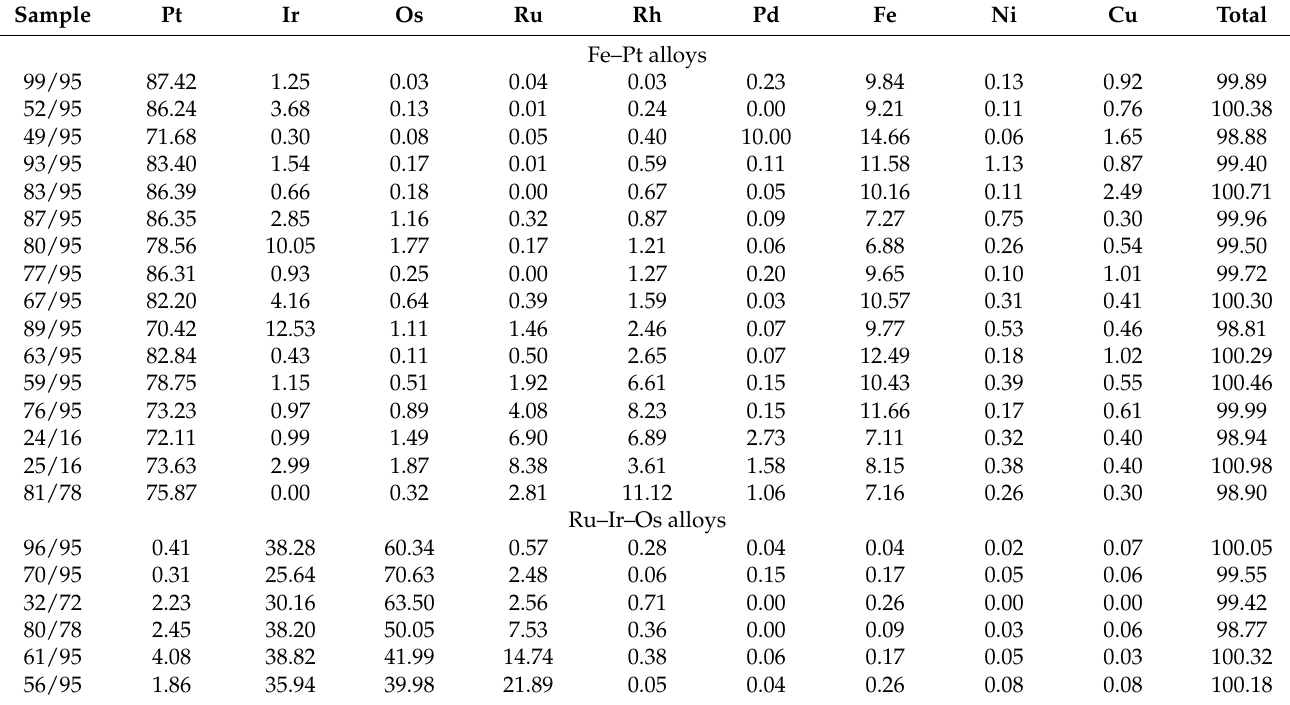
Table A1. Representative analyses of platinum group minerals from placers Anabar R.,